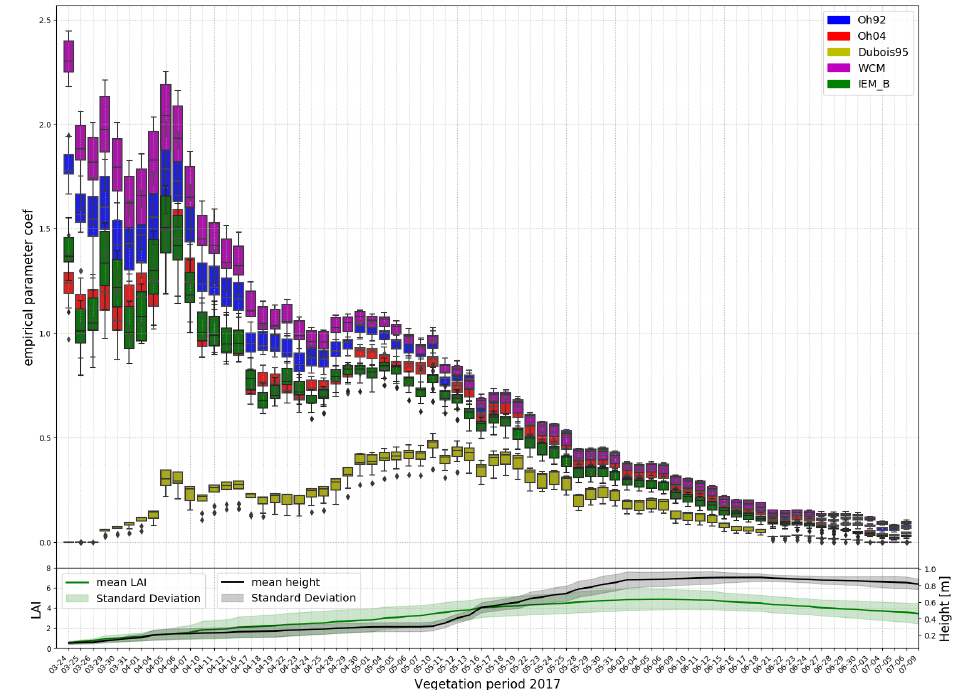
Figure 8. Evolution over time of non-static parameter coef separated by different surface models (colors) for each Sentinel-1 acquisition date during vegetation period 2017. The box plots show the range of coef used during the validation approach for different fields point ( top ). Mean and standard deviation of all measurement points for LAI and canopy height ( bottom